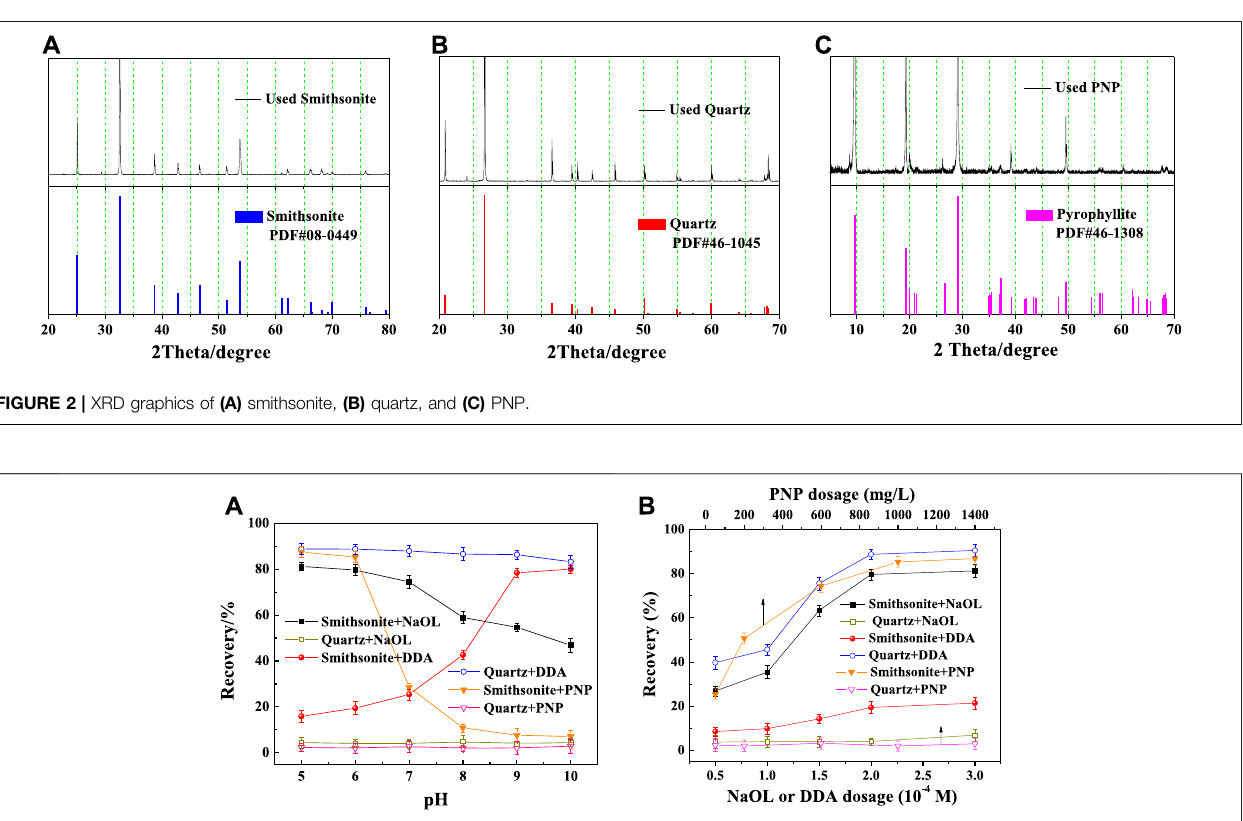
FIGURE3| EffectofpulppHonthe fl oatabilityofmineralsincollectorsolution[ (A) ,NaOLandDDA2 × 10 – 4 M,PNP1 g/L];andtheeffectofcollectordosageonthe fl oatability of minerals [ (B) , pH 6.0].